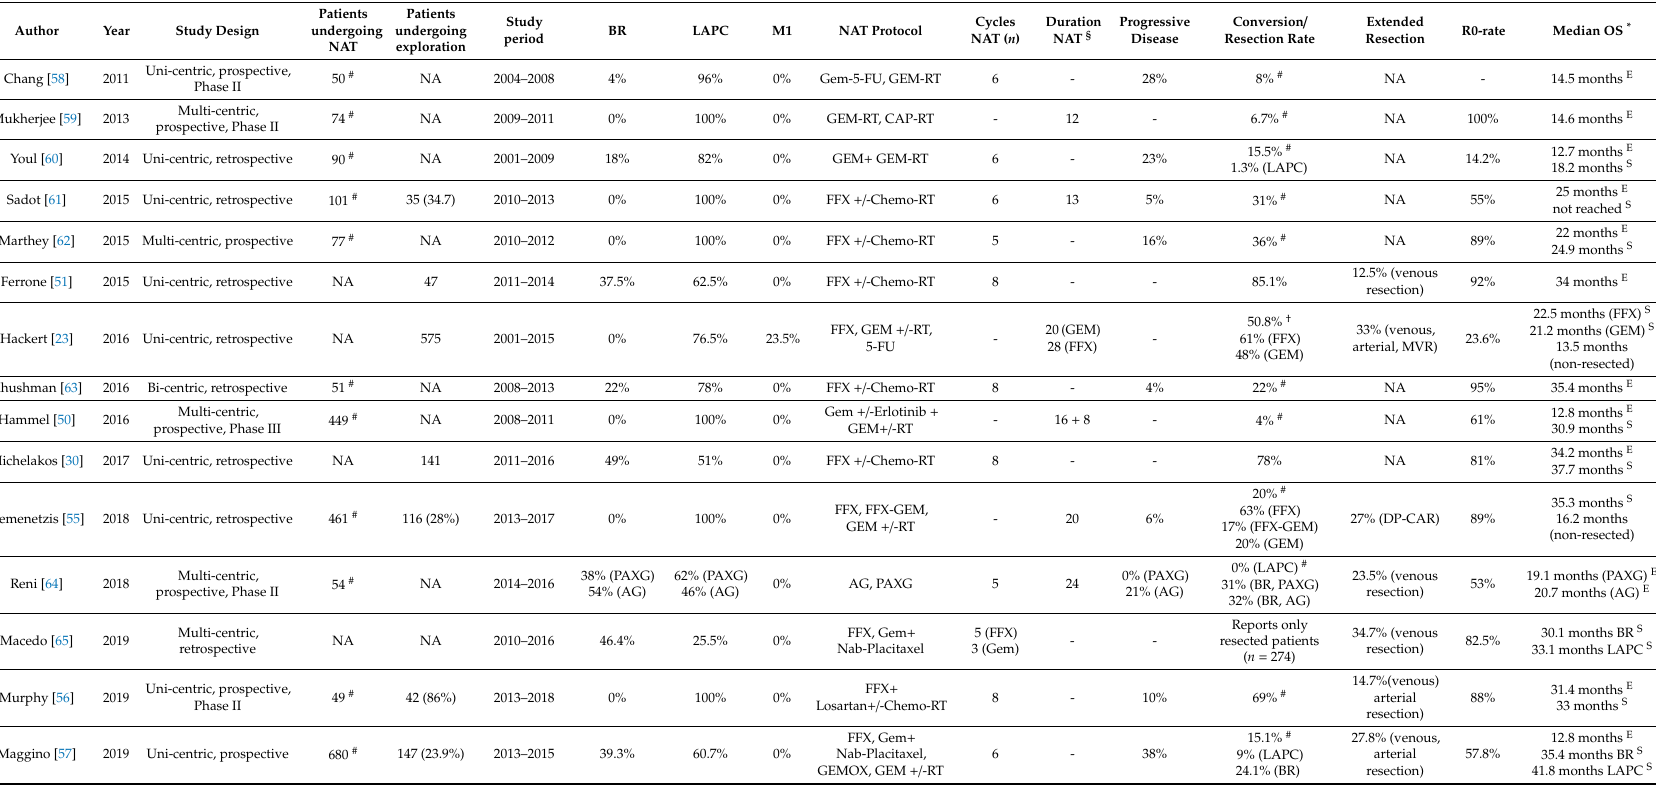
Table 1. Overview of neoadjuvant chemotherapy regimens and resection rates for advanced pancreatic